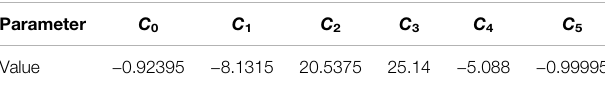
TABLE 4| Controlparameters ofBernsteinbasisfunctionsforoptimized solar fl ux